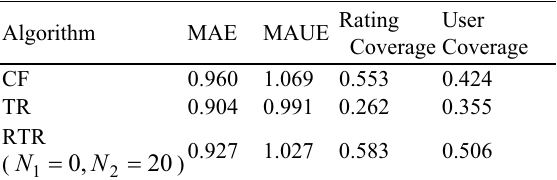
Table 6. The results of running CF,TR and RTR on Epinions. Algorithm